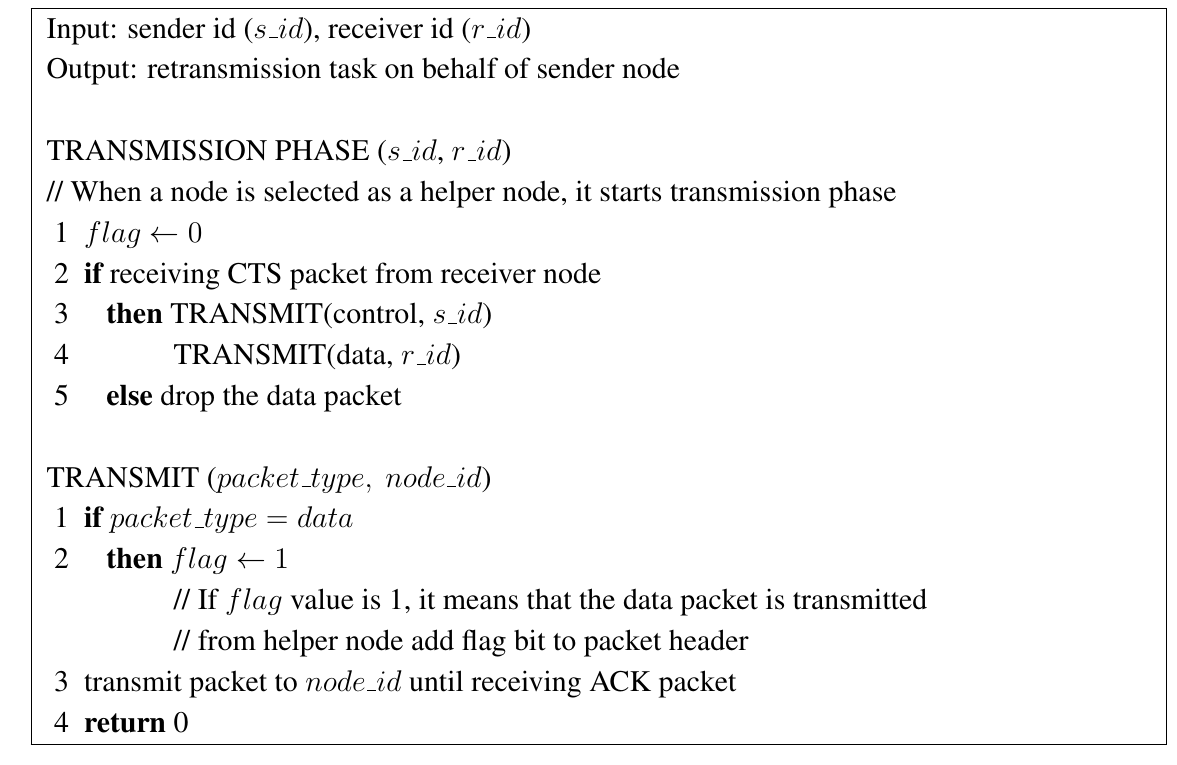
Table 2. Pseudo-code of transmission